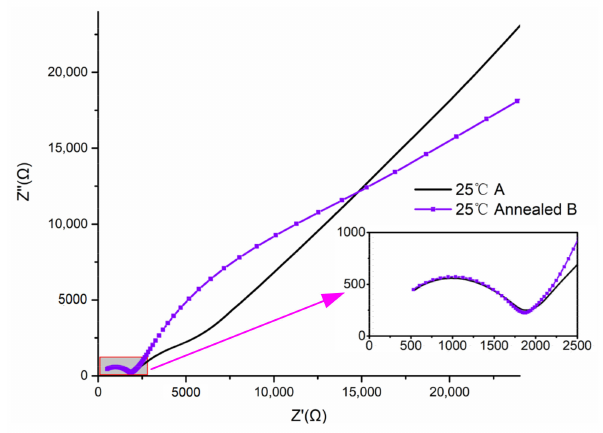
Figure 7. AC impedance test at 25 ◦ C for the annealed electrolyte of Group B.